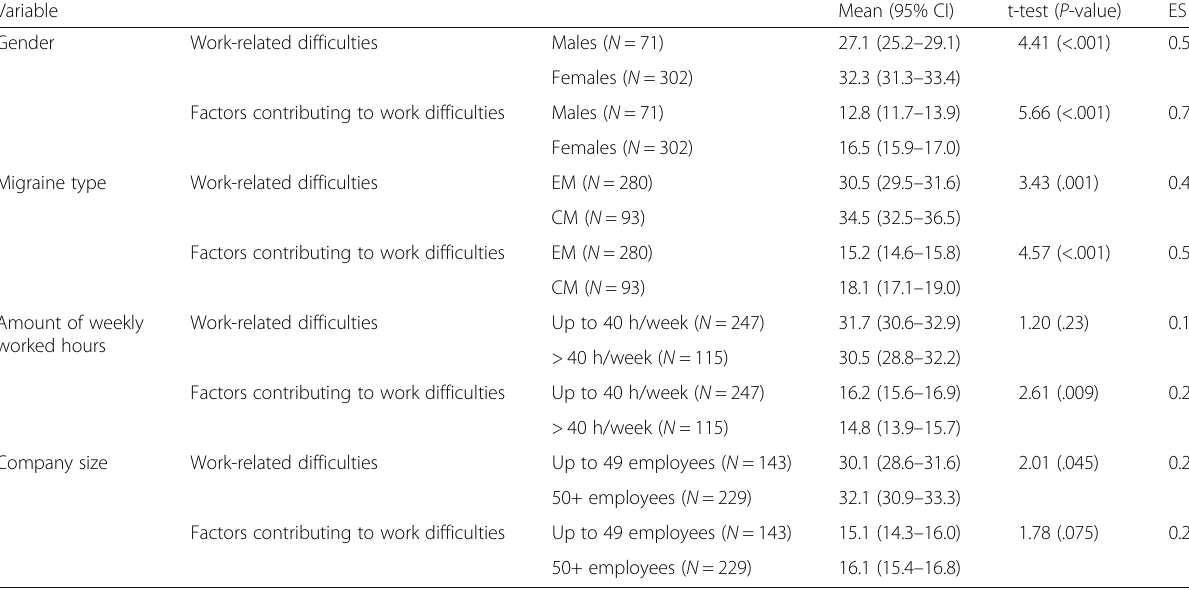
Table 4 Independent sample t-test assessing differences in HEADWORK scales based on gender, migraine type, amount of weekly worked hours and company size